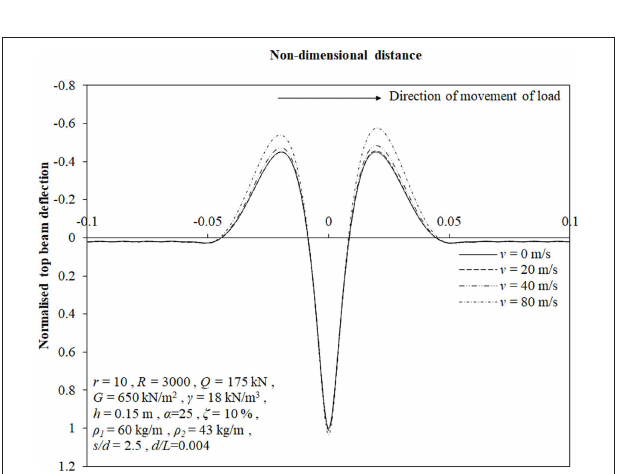
FIGURE 13 | Deflection of top beam at different velocities of applied